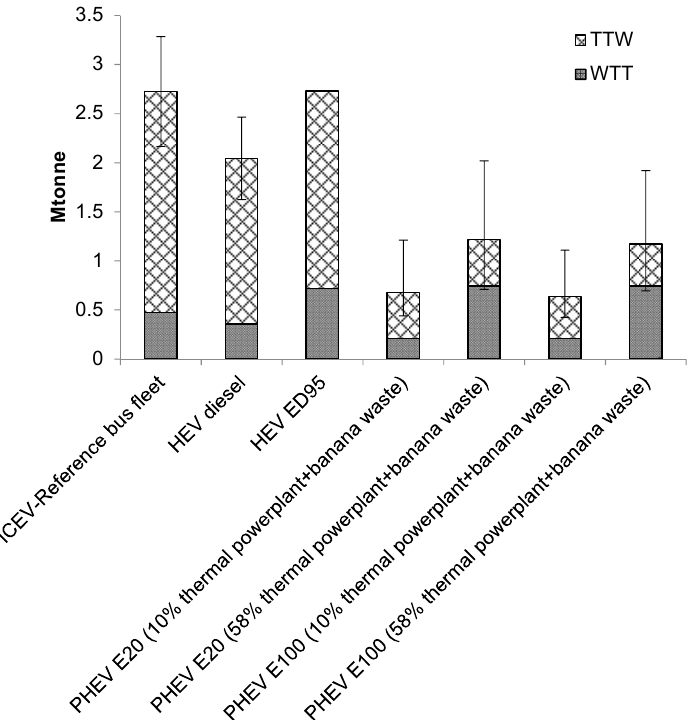
Figure 7. WTW CO 2 emissions for Ecuadorian bus fleet in millions ton/year, with uncertainty (range based with uniform distribution).